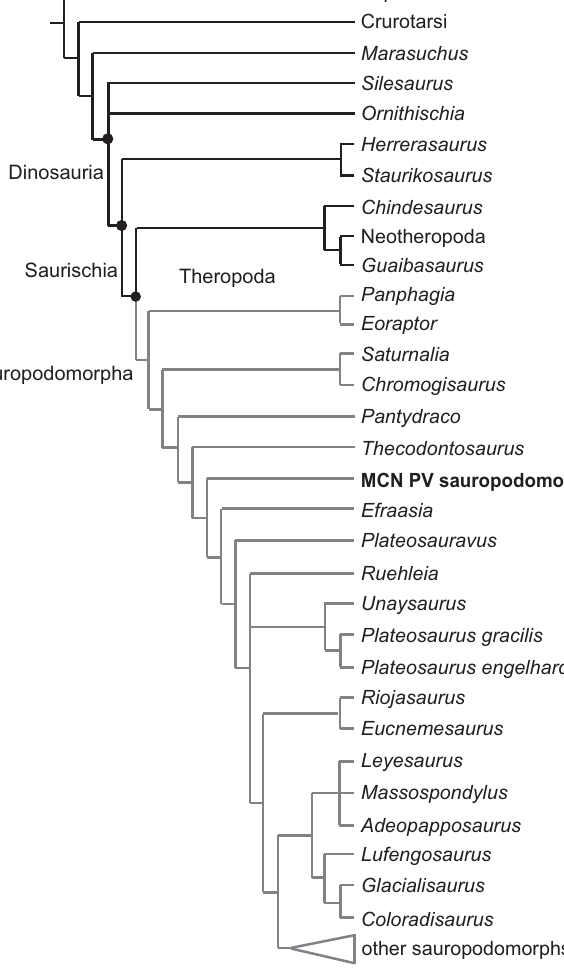
Fig. 10. Strict consensus tree of 2052 MPTs found in the analysis of the data matrix of Bronzati et al. (2018), showing the phylogenetic relation- ships of MCN PV sauropodomorph among Triassic sauropodomorphs and other